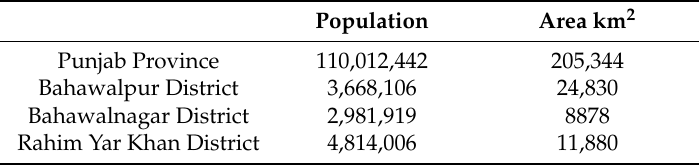
Table 1. The population of Punjab province and the three districts.